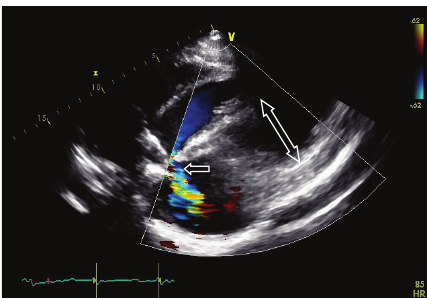
Figure 1: Color Doppler image shows flow from the left ventricle through the fistulous tract (single head arrow) into the pericardial